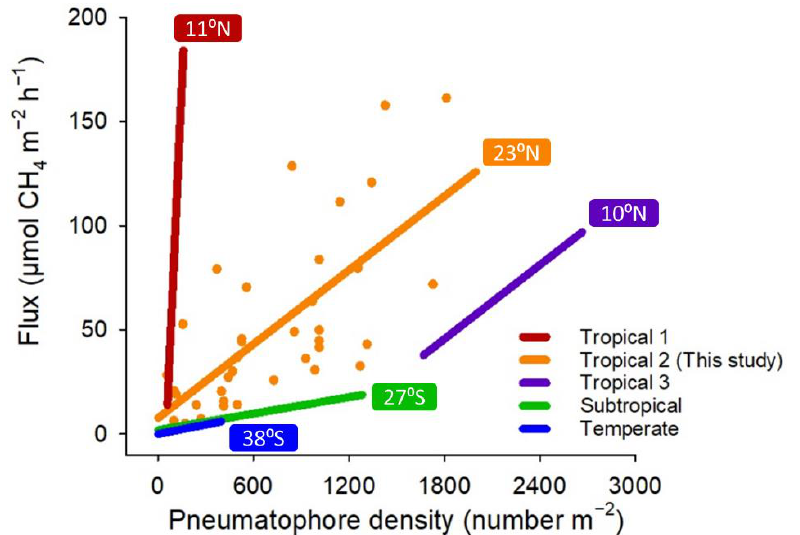
Figure 8. Comparisons of linear regression lines of CH 4 emissions on pneumatophore density in A. marina mangroves in different climatic regions. The numbers in color frames represent the latitudes of the studied sites. Tropical 1: Purvaja et al. [36]; tropical 3: Krithika et al. [25]; subtropical: Kreuzwieser et al. [44]; temperate: Livesley et al. [26]. Sampling time: tropical 1: pre-monsoon, monsoon, post-monsoon, and summer; tropical 3: dry and wet; subtropical: spring and winter; temperate: spring, summer, fall, and winter.